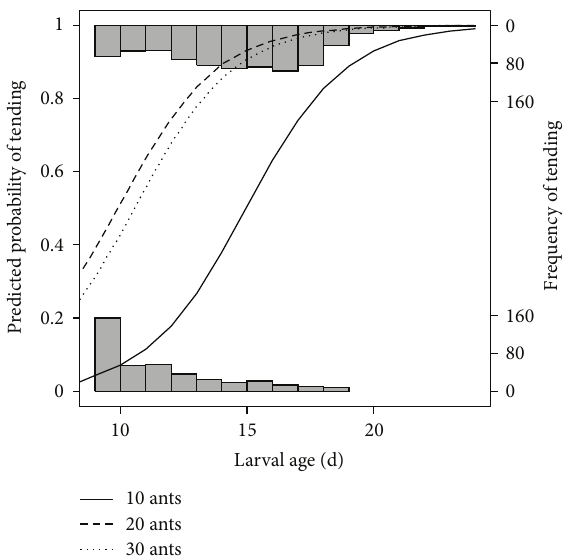
Figure 2: Fitted logistic regression curves showing the predicted probability of ant tending (left 𝑦 -axis) as a function of larval age for the three ant abundance treatments in this study. The histograms show the frequency of observations in which tending occurred (upper right 𝑦 -axis) or did not occur (lower right 𝑦 -axis) each day for the three ant abundance treatments combined. Results of statistical analyses on the effects of ant abundance treatment and larval age are in Table 1.